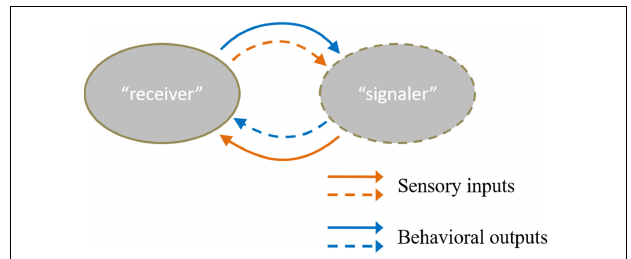
FIGURE 1 | There are two kinds of sensory inputs and behavioral outputs between “receiver” and “signaler” (Chen and Hong, 2018). The solid line means the sensory cues “receiver” received and the behavior that the “receiver” conducts. Moreover, the dotted line refers to the sensory cues “signaler” received and the behavior the “receiver” acts. The orange color line describes the input and output information of the “receiver”. The blue color line referred to input and output information of the